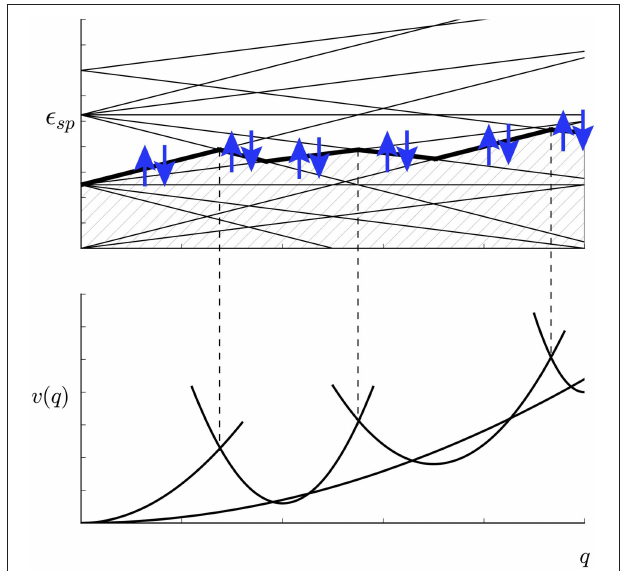
FIGURE 1 | The schematic evolution of the single-particle nucleons levels (Upper panel) and of the total nuclear energy (Lower panel) as a function of deformation parameter q [10, 16, 17]. The thick line represents the Fermi level and the up/down arrows depict the Cooper pairs of nucleons on the Fermi m ). This figure is reproduced from level only, in time-reversed orbits ( m , − Bulgac et al. [ 17] under the terms of the American Physical Society copyright